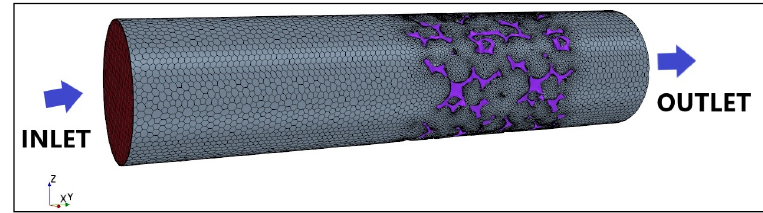
Figure 6. Polyhedral mesh with overlapped zone occupied by fluid flow.